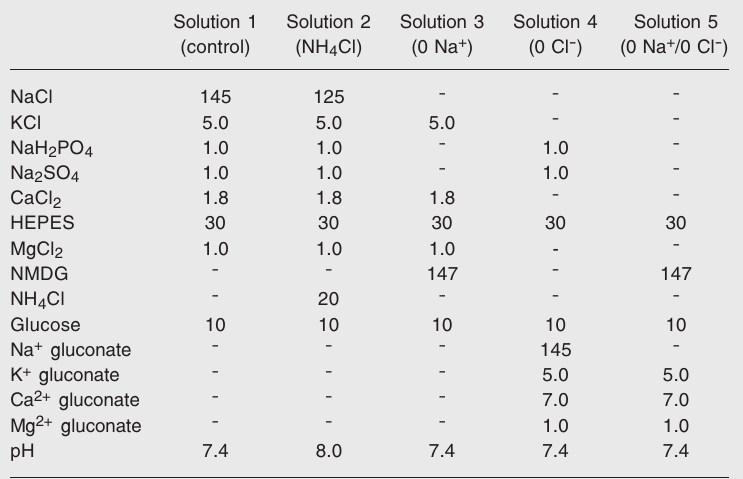
Table 1. Composition of the solutions used in the present